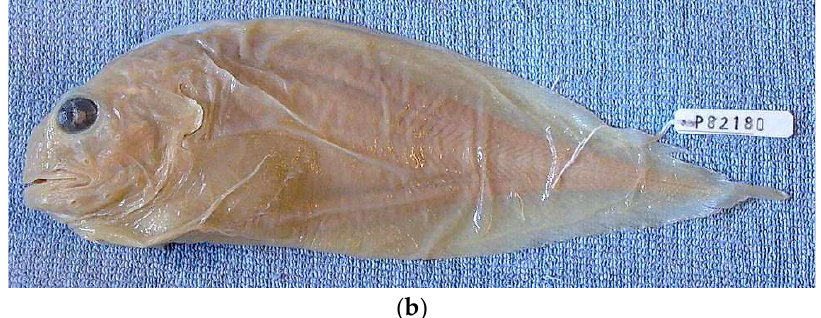
Figure 5. Arctic species of Careproctus : ( a ) C. reinhardti , Baffin Bay, ZMUC P82456; ( b ) C. longipinnis , Holotype ZMUC P82180, TL 221 mm.